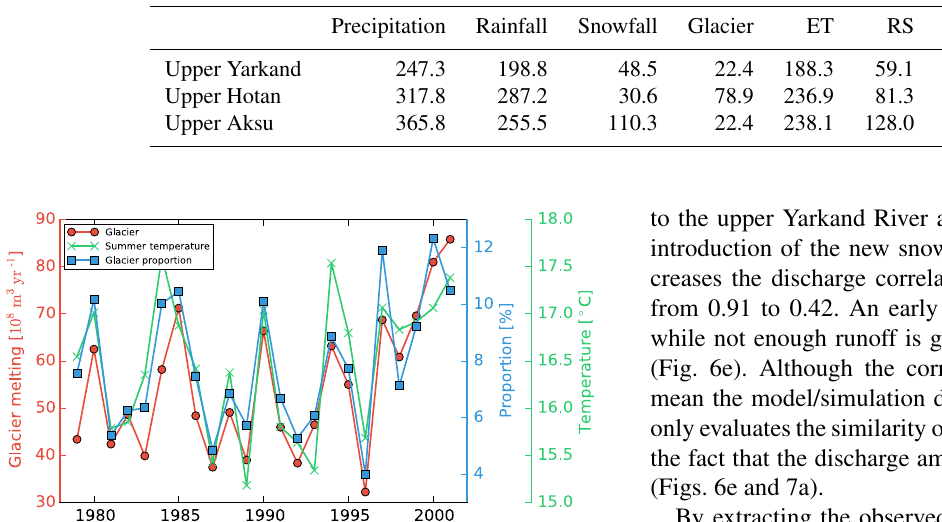
Table 4. The water–energy components for the headwater catchments in WFDEI-CCG-SF simulation. Units: mmyr − 1 .